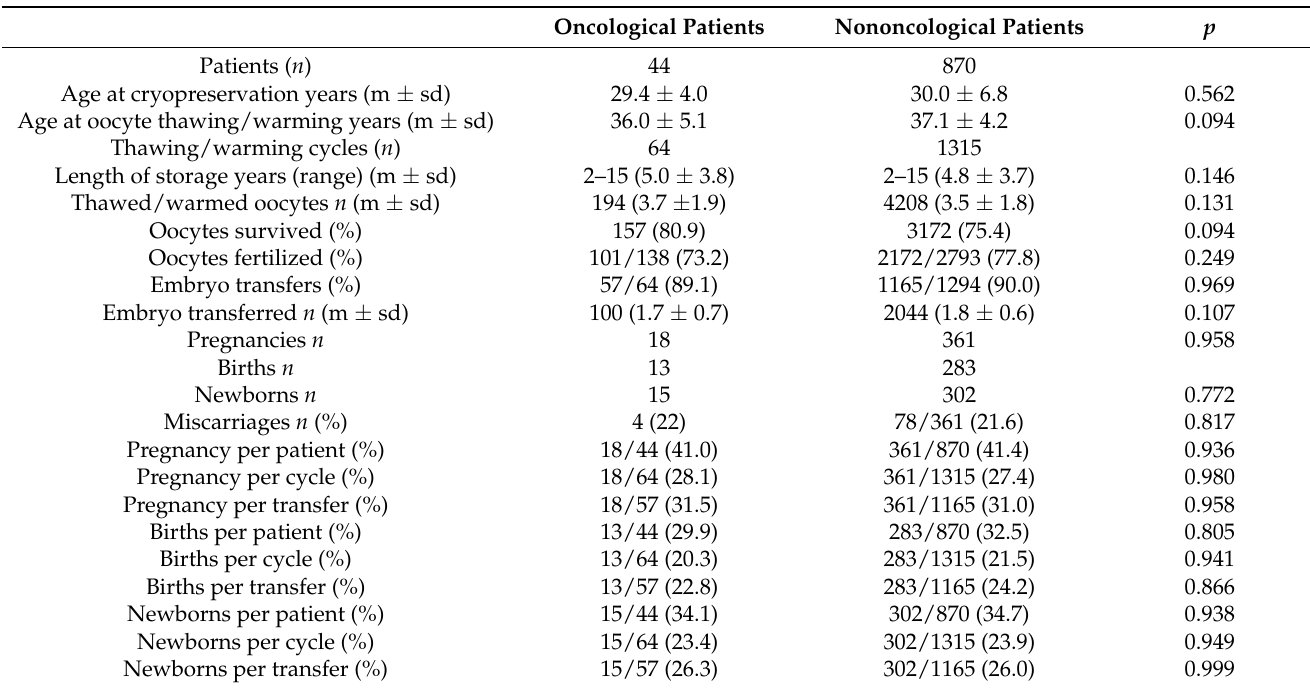
Table 3. Results of oocyte thawing/warming cycles in oncological patients vs. nononcological